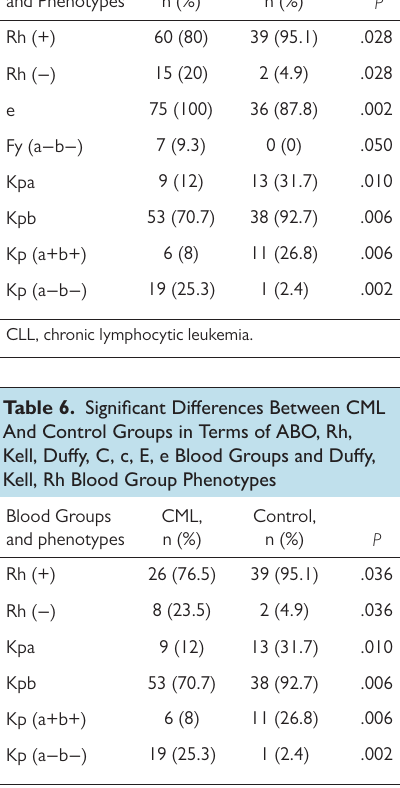
Table 5. Significant Differences Between CLL and Control Groups in Terms of ABO, Rh, Kell, Duffy, C, c, E, e Blood Groups and Duffy, Kell, Rh Blood Group Phenotypes Blood Groups and Phenotypes